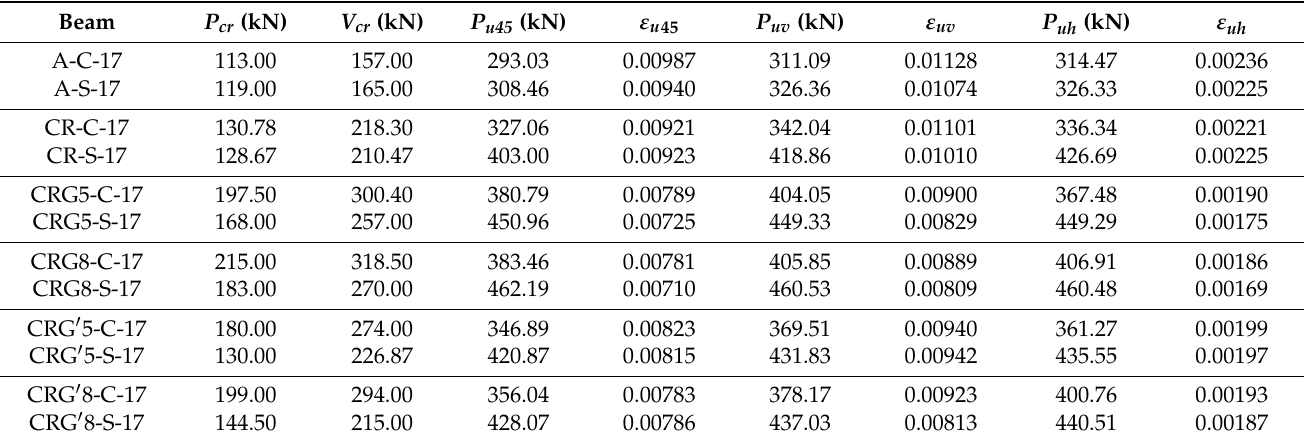
Table 8. Summary of loads and strain of the